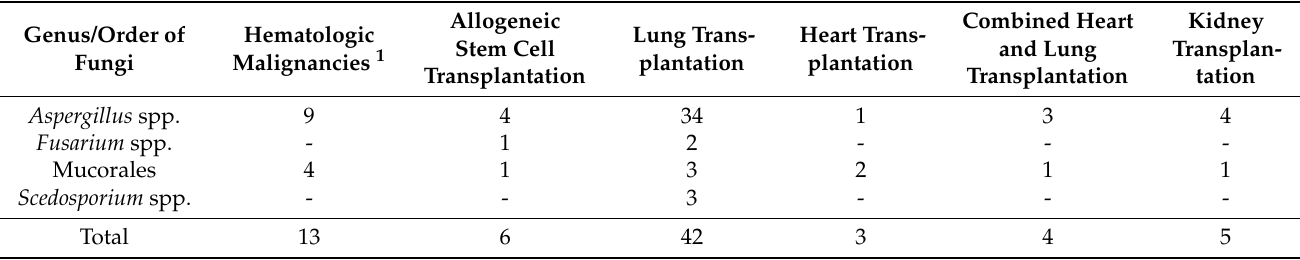
Table 3. Filamentous fungal isolates in probable or proven invasive infection of the four most common genera among high-risk patients.